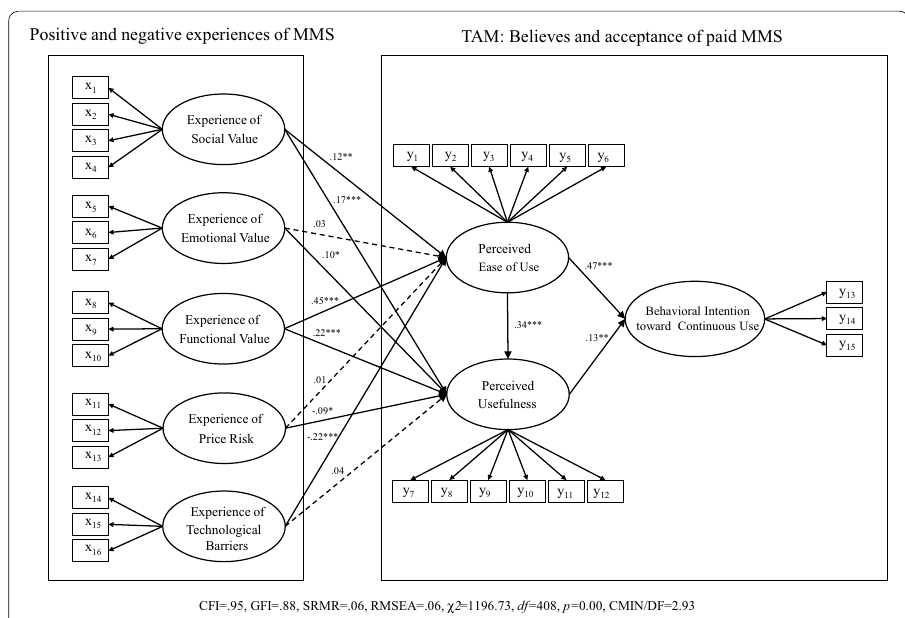
Fig. 3 Path coefficients of latent